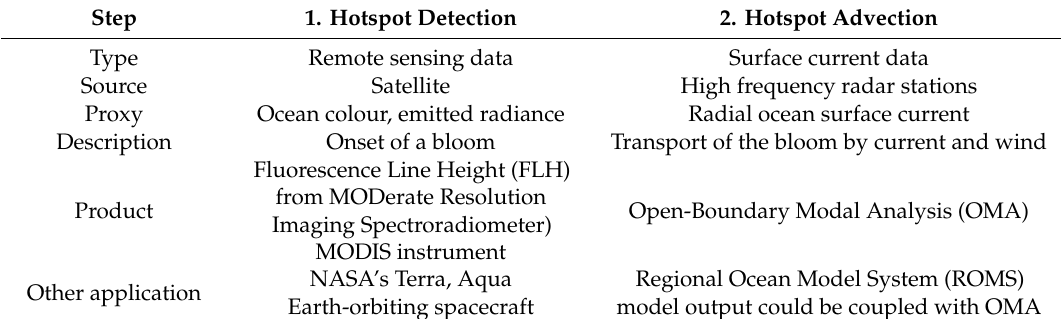
Table 6. Predictive computation process, consisting of two steps: detection and advection developed from